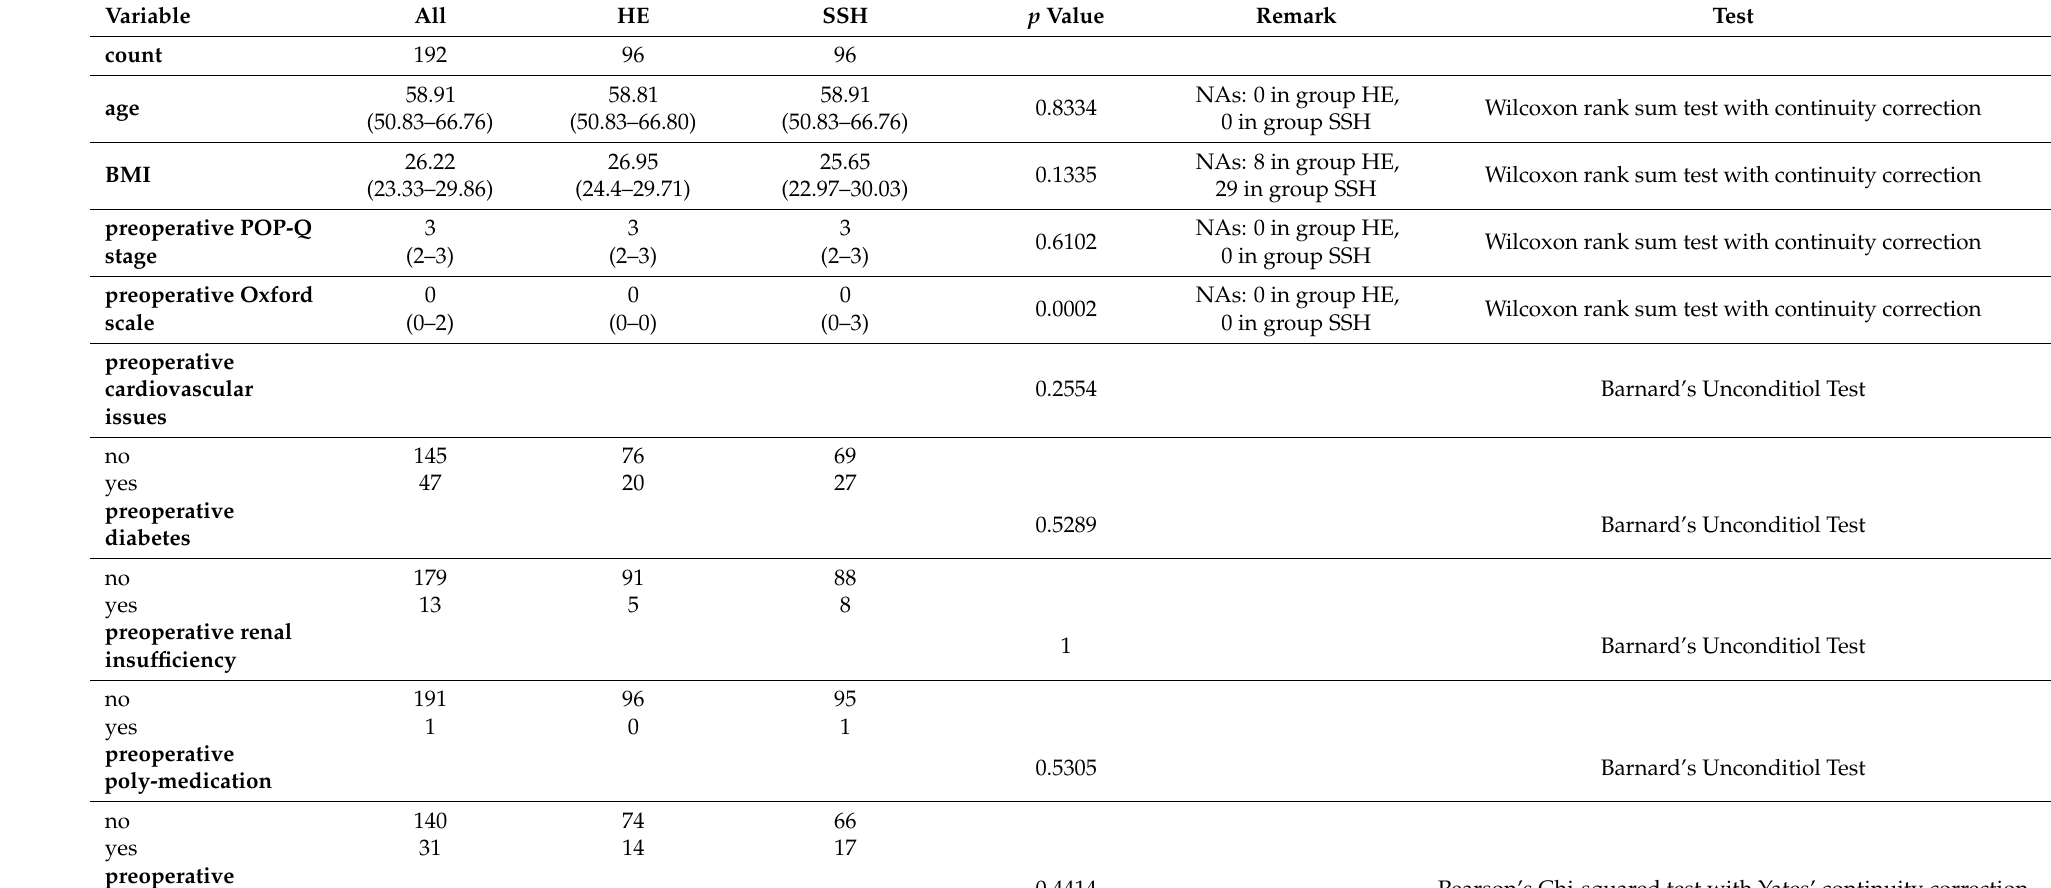
Table 1. Patients’ baseline